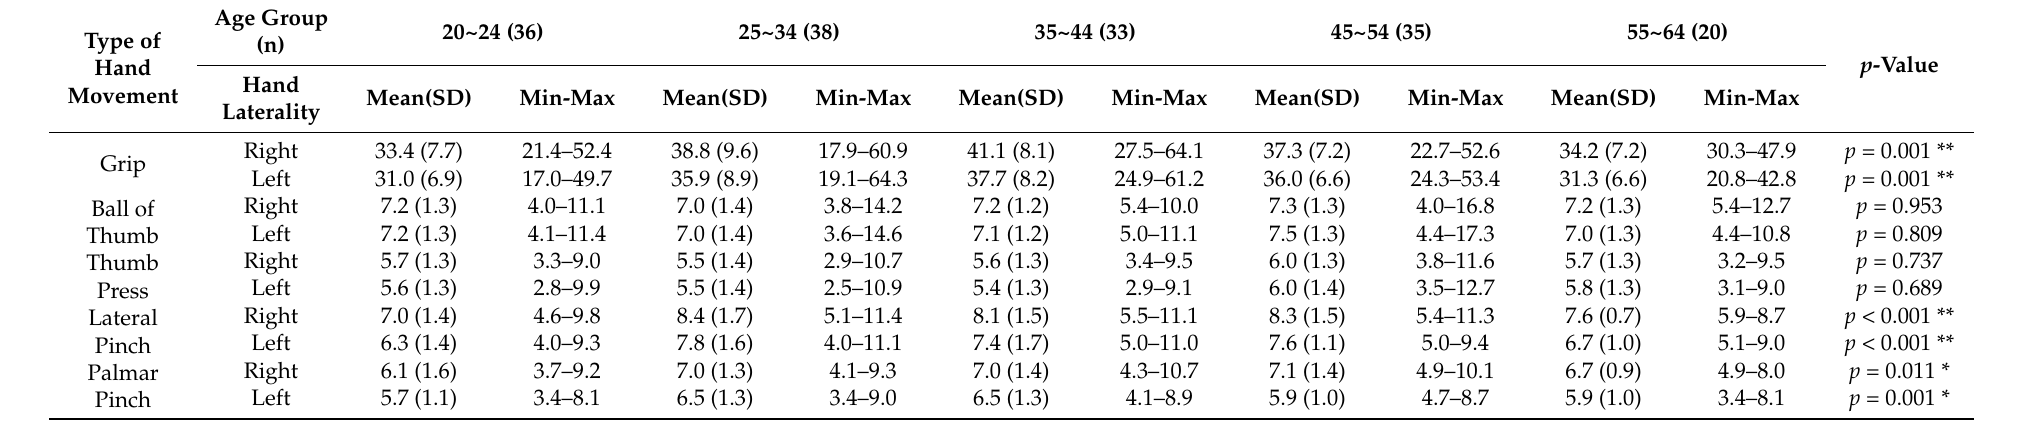
Table 3. Summary of Strength data by age, type of hand movements and hand laterality among males ( n = 162, unit: kgw).